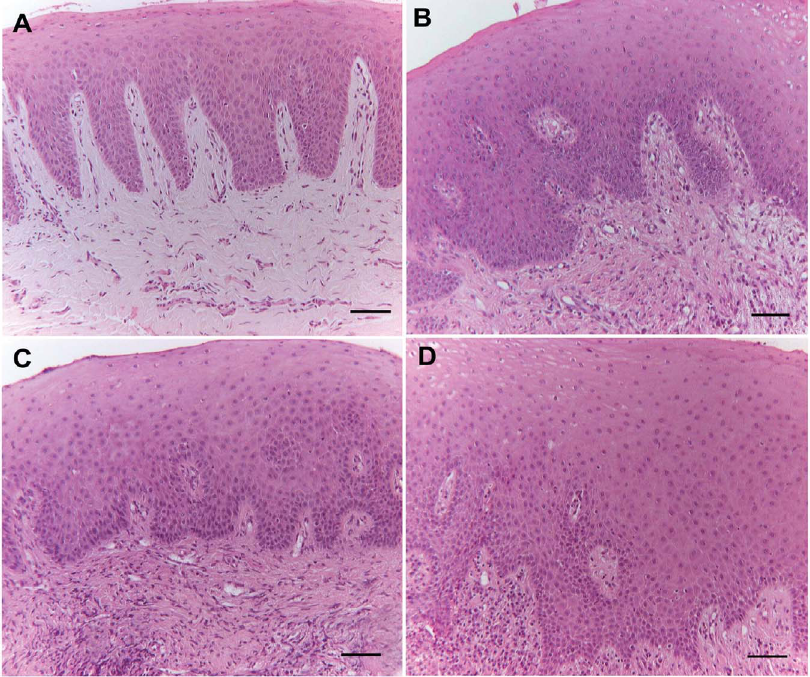
Figure 1. Haematoxylin and Eosin staining of periodontal tissues. A) healthy gingiva; B) gingivitis tissue; C) chronic periodontitis tissue; D) aggressive periodontitis tissue. Original magnification: 200x; scale bar: 50 m